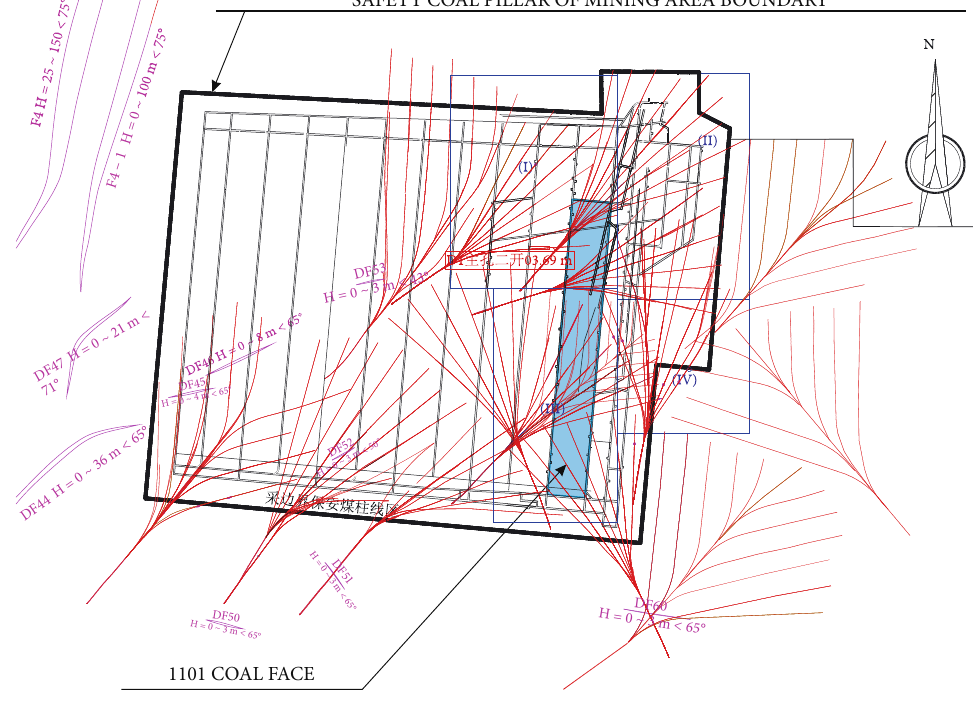
Figure 3: Layout of directional drilling and grouting in Xujiazhuang limestone